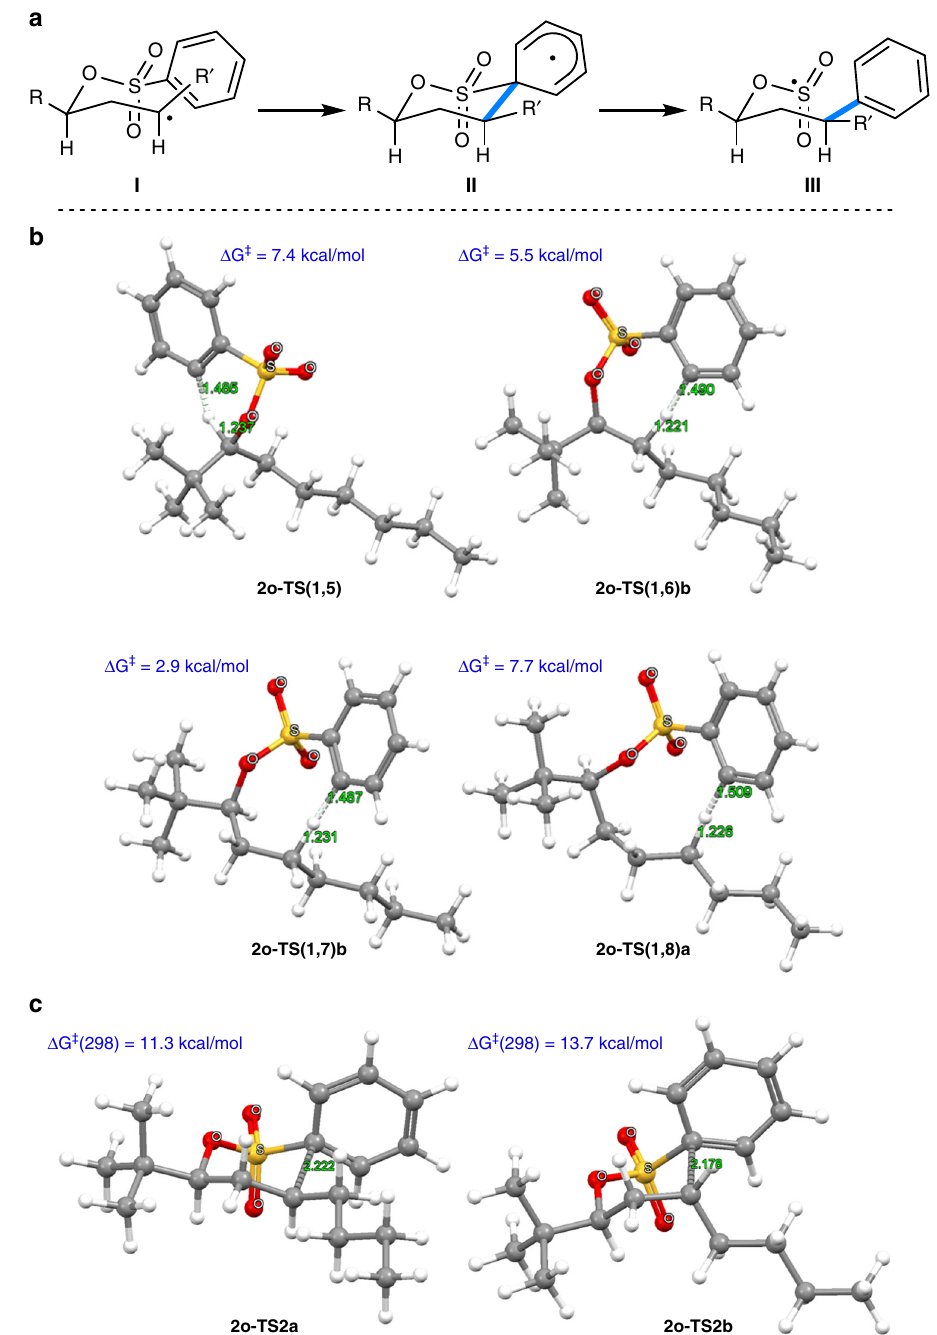
Fig. 4 Regioselectivity and stereoselectivity of the remote C − H arylation. a Model to explain the stereochemical outcome of the radical phenyl migration reaction. b DFT studies on the regioselectivity in a non-cyclic system. Transition state structures with relative activation energies for the 1,5-, 1,6-, 1,7-, and 1,8-H translocation in the radical derived from 2o . Only the more favorable transfer of two hydrogens at positions 6, 7, and 8 is shown. c Stereodetermining step in the arylation of secondary C − H bonds ( I → II ): transition structures leading to cyclohexadienyl radicals formed as intermediates in the